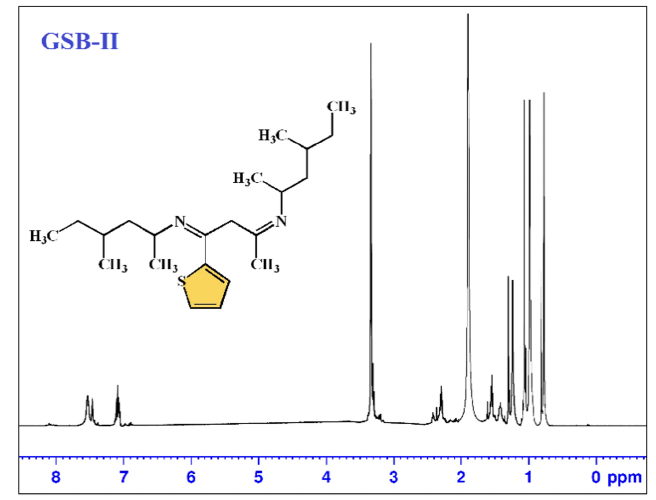
Figure 2. H 1 NMR spectrum of GSB compounds.